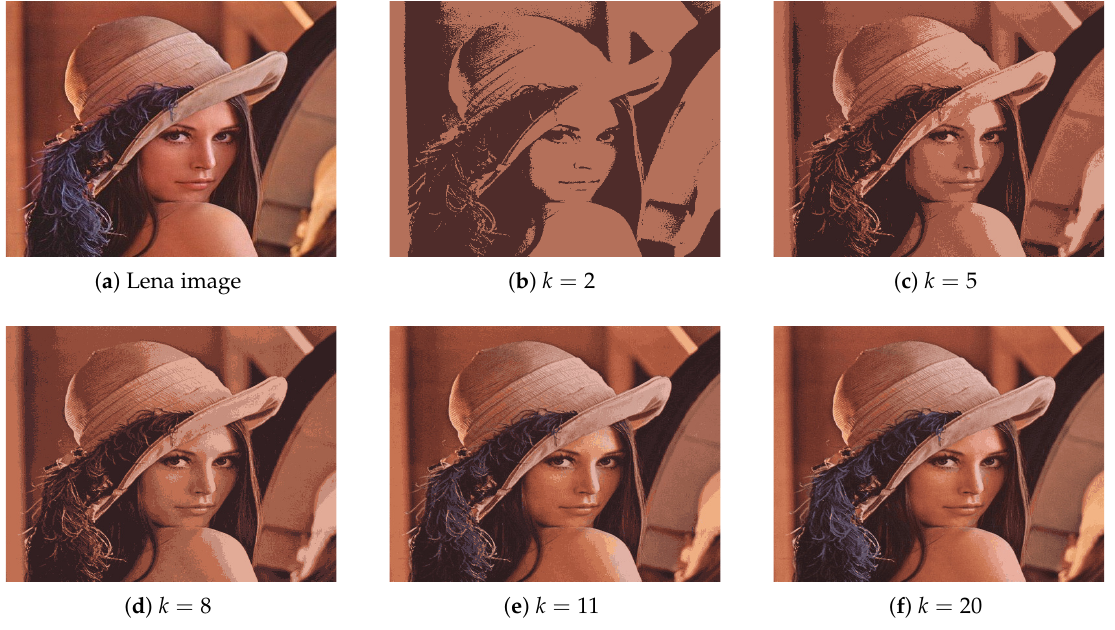
Figure 2. The image segmentation for the Lena image. ( a ) The original Lena image. ( b – f ) The clustering images when the number of clusters k = 2, 5, 8, 11 and 20, respectively.